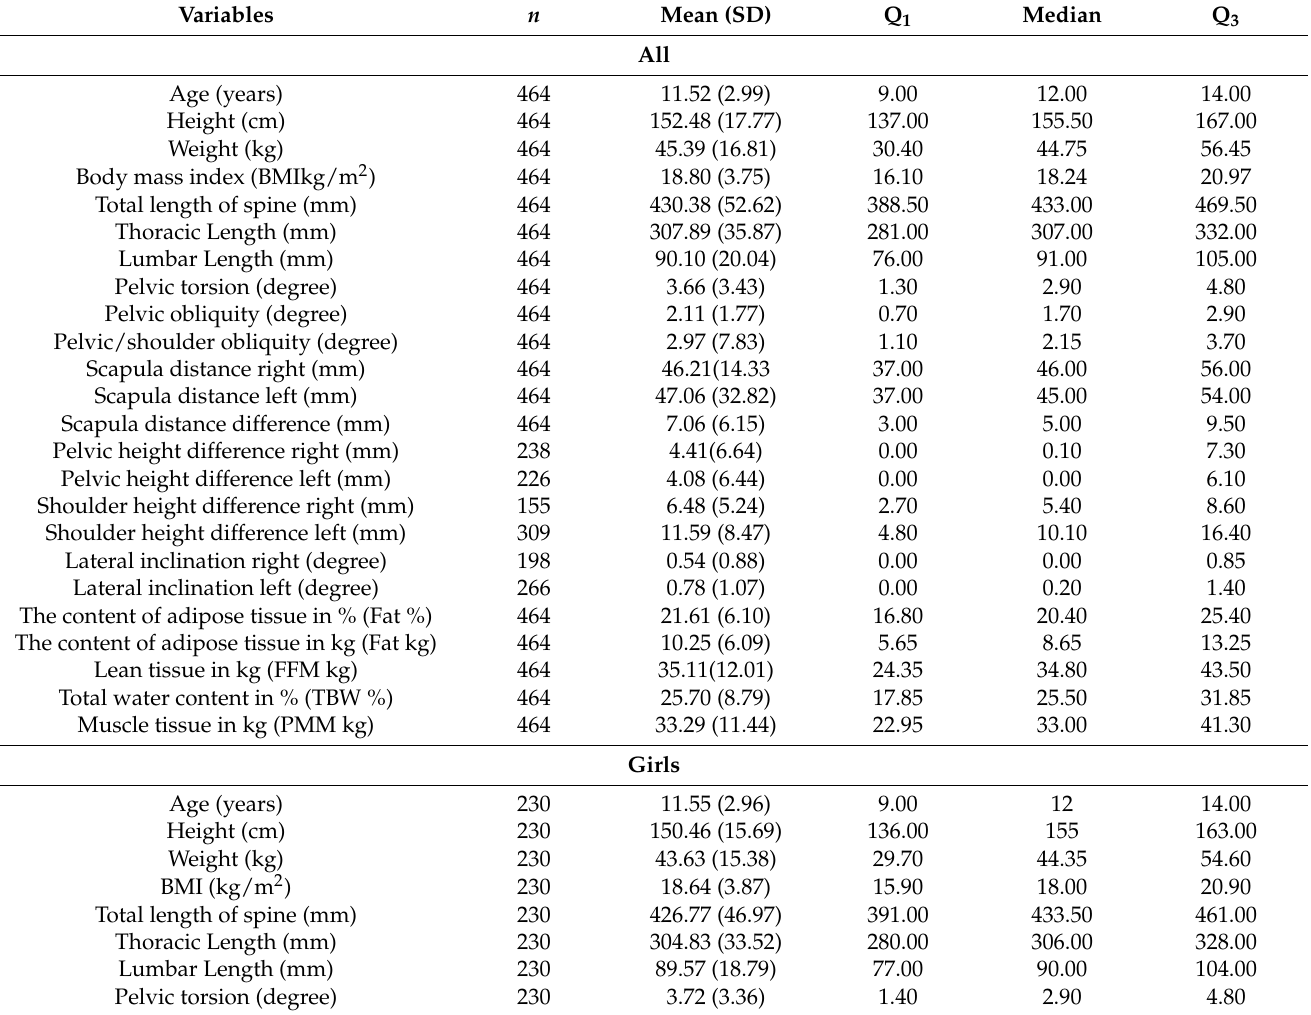
Table 1. Characteristics of the study